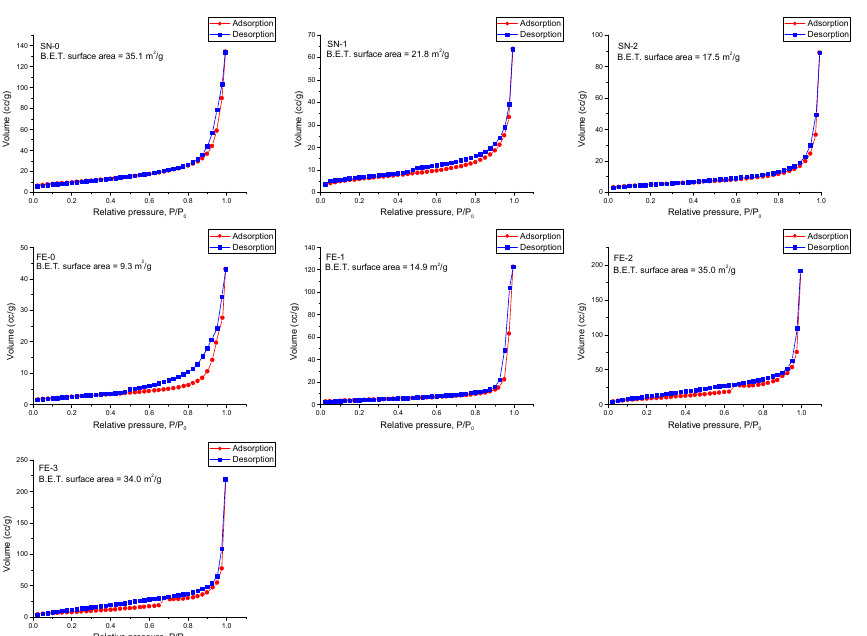
Figure 9. Gas (N2) adsorption (red line, circle) and desorption (blue line, squares) isotherms of samples SN-0, SN-1, SN-2, FE-0, FE-1, FE-2 and FE-3.